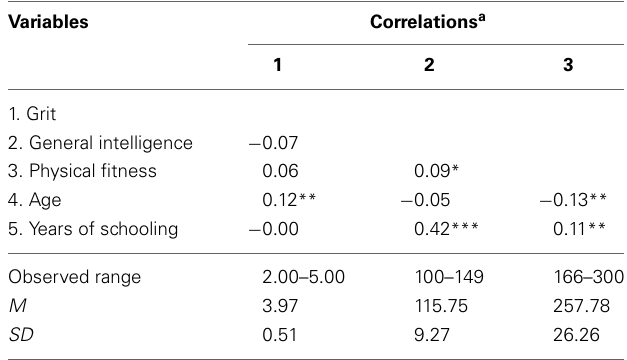
Table 1A | Summary statistics and intercorrelations among ARSOF candidates (Study